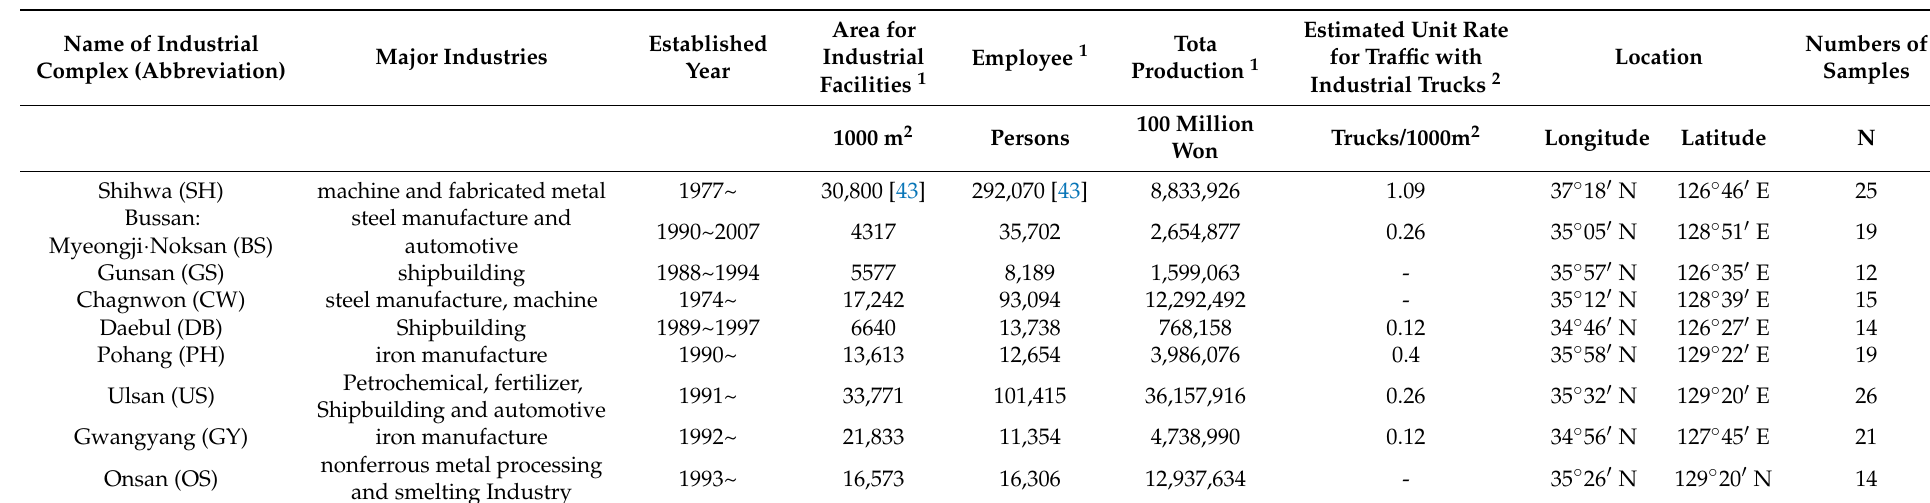
Table 2. Details and information of nine evaluated industrial complexes in